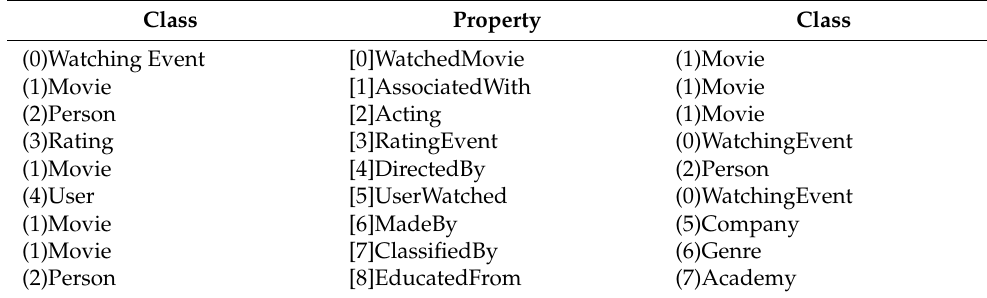
Table 1. Ontology graph data structure.